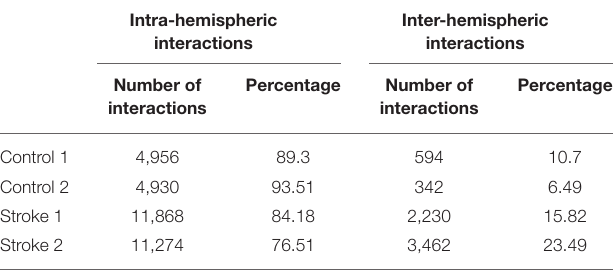
TABLE 5 | Number and percentage of intra-hemispheric vs. inter-hemispheric interactions represented by non-zero LCD model coefficients. Intra-hemispheric Inter-hemispheric interactions